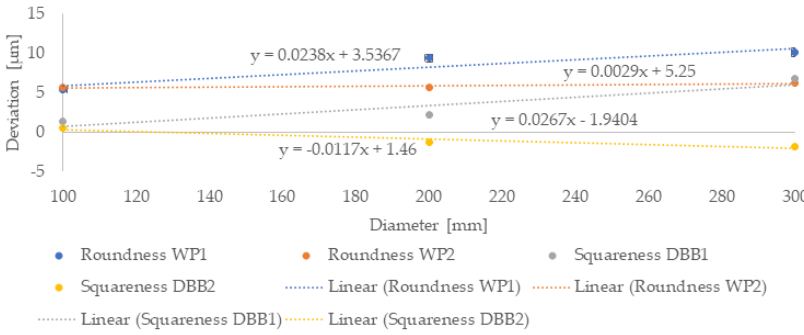
Figure 19. Description of roundness and squareness errors by machined diameter size.